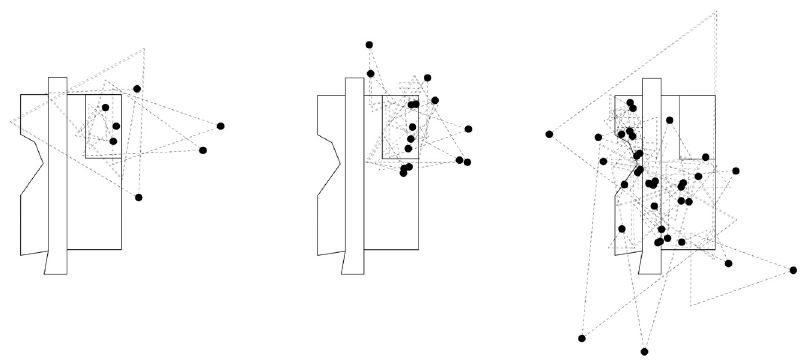
Figure 3. POV/FOV maps of the MTCC. From left: (a) Photographs within the Hedrich-Blessing collection; (b) Photographs from Google Image; (c) Photographs from GA Document 76. Diagrams by